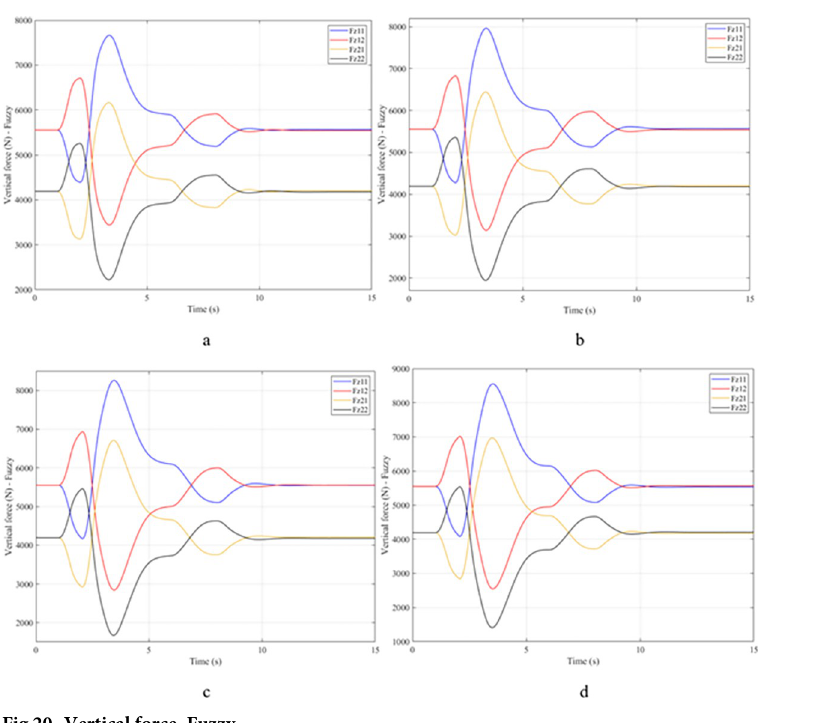
Fig 20. Vertical